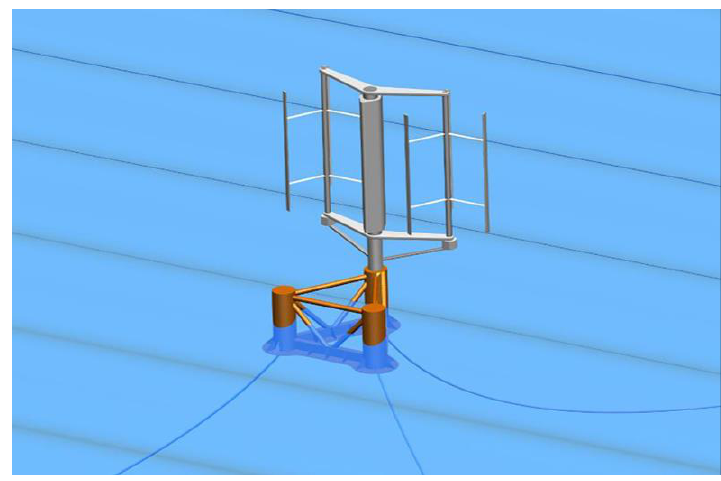
Figure 1. Concept design of an offshore floating twin vertical-axis wind turbine system.